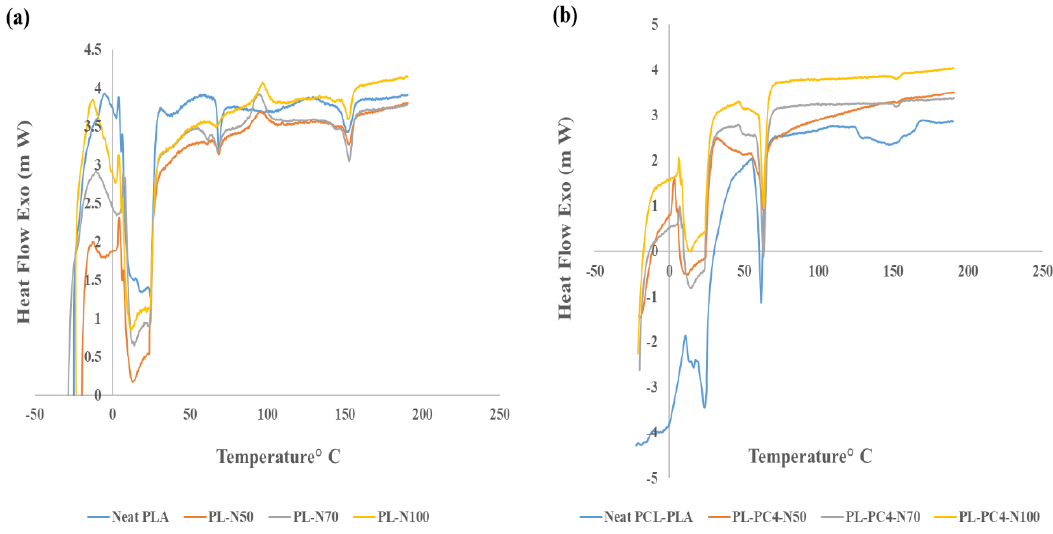
Figure 4. ( a ) Differential scanning calorimetry (DSC) graphs for neat and porous PLA films ( b ) DSC graphs for neat and porous PCL/PLA films. Table 4. Thermal properties of neat and porous PLA and PCL/PLA films.